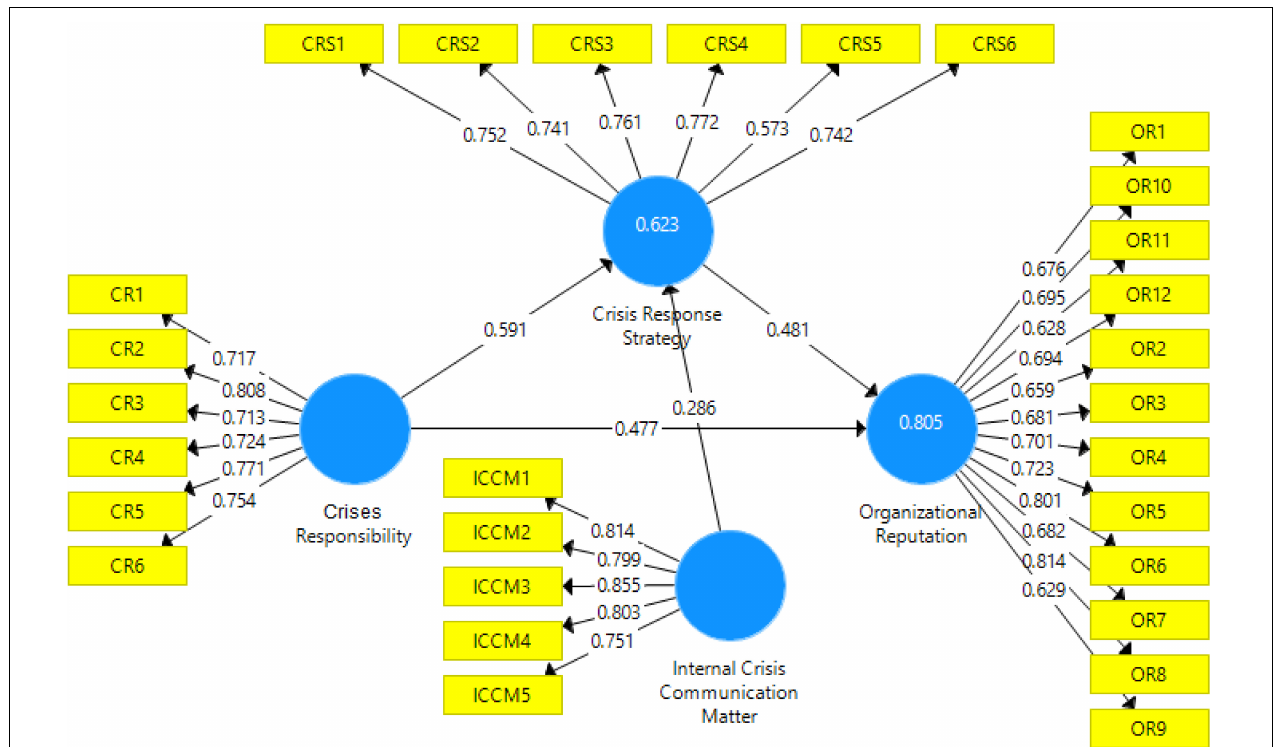
FIGURE 1 | Measurement